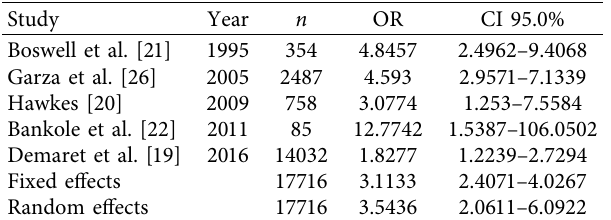
Figure 3: (a) Heterogeneity analysis using Galbraith plot, (b) publication bias by funnel plot, and (c) meta-analysis by forest plot. Table 3: Odds ratio meta-analysis of failed endotracheal intubation in pediatric and adult patients.